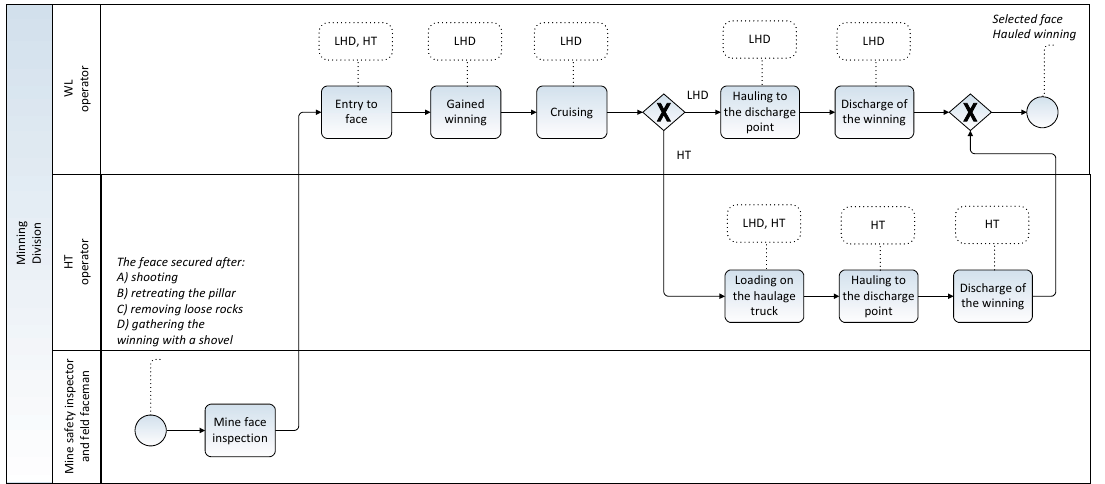
Figure 2. The process of loading and unloading the winning recorded in business process model and notation (BPMN) [22].